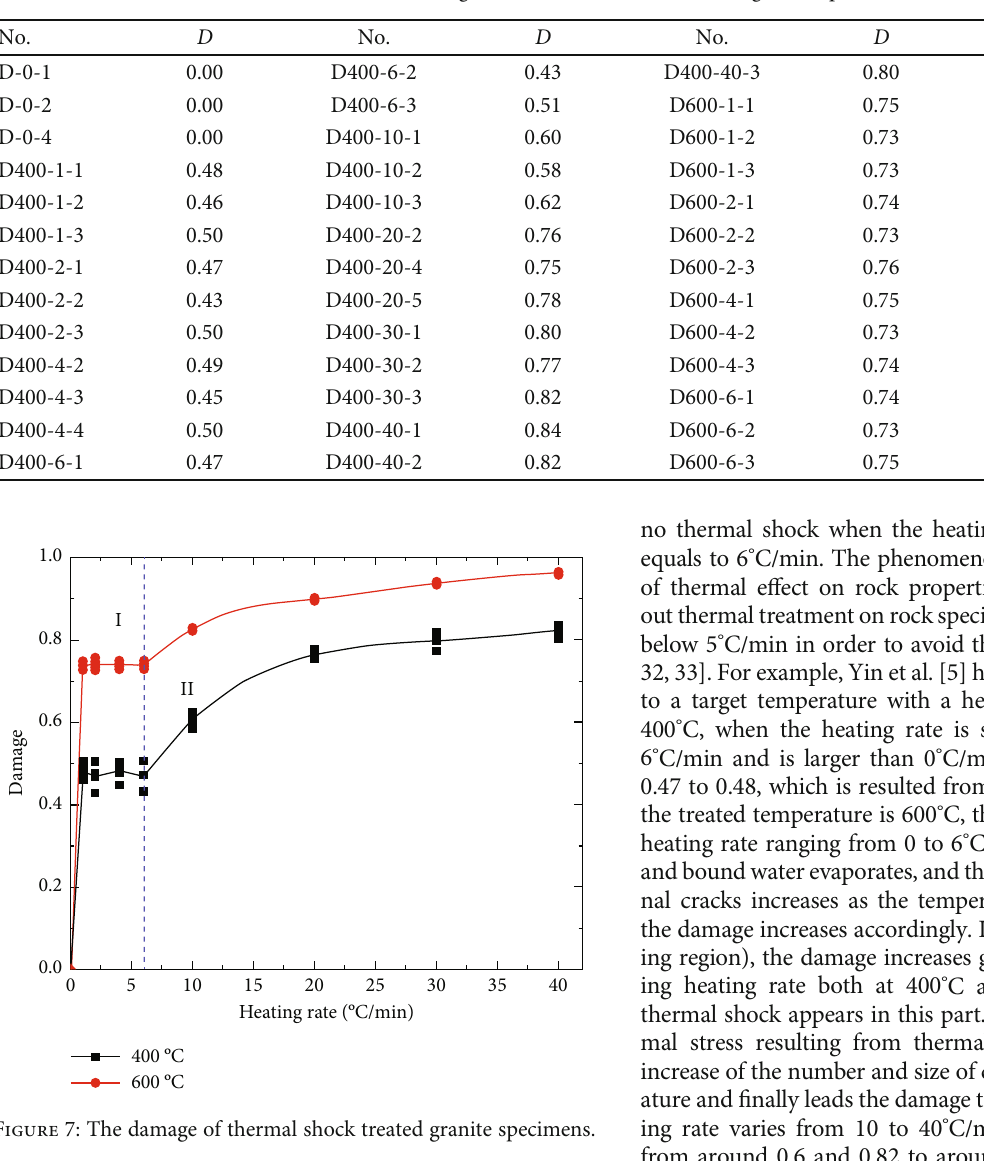
Table 2: Damage ( D ) of thermal shock treated granite specimens.